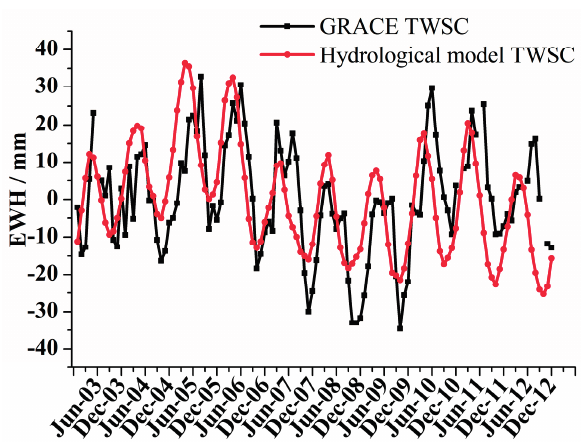
Figure 3. Comparison between terrestrial water storage changes (TWSC) derived by GRACE and hydrological models.